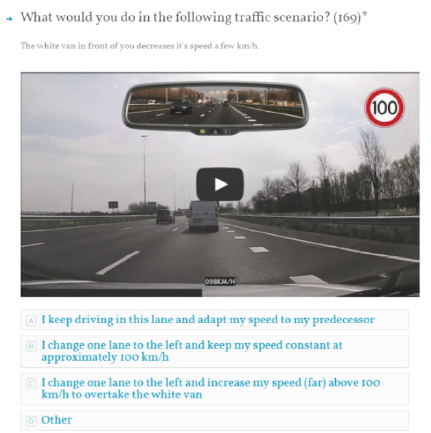
Figure 1: Screenshot of a video clip.